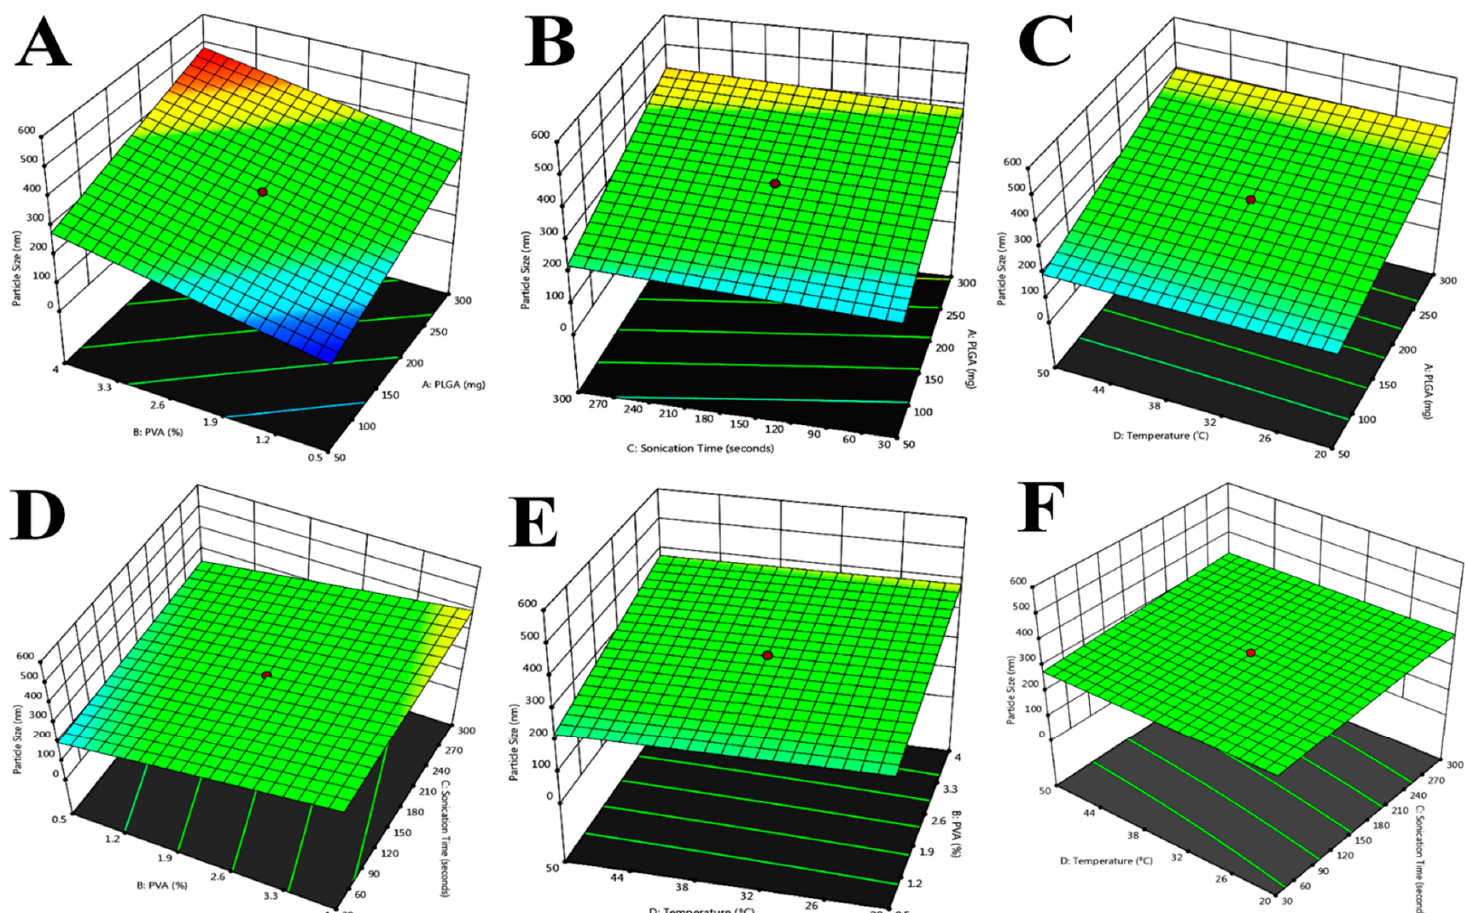
Figure 1. Response surface plot showing the effect of independent variables on particle size. PVA, PLGA. ( A ). Particle size, PLGA, sonication time; ( B ). Particle size, PLGA, temperature; ( C ). Particle size, PVA (%), sonication time; ( D ). Particle size, PVA (%), temperature (°C); ( E ). Particle size, PVA (%), temperature (°C); ( F ). Particle size, sonication time, temperature (°C).